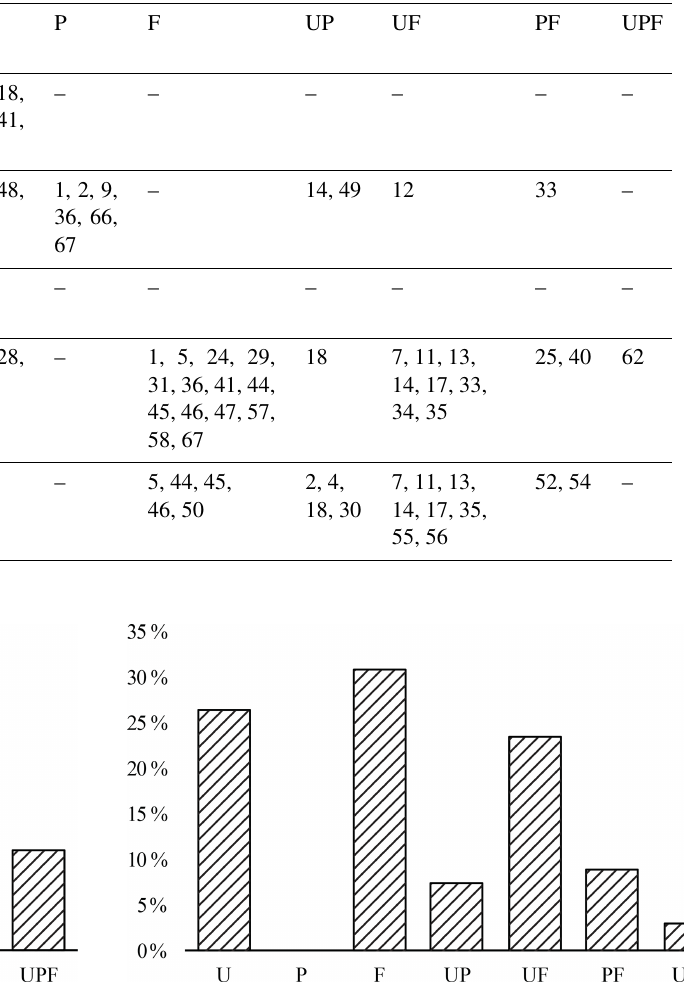
Figure 5. The frequency (as a percentage) of the device fold states when performing a function.